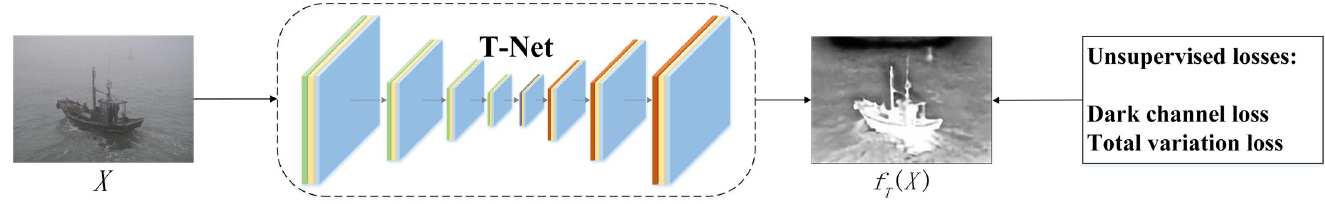
Fig 6. Transmission map estimation branch, dark channel loss and total variation loss are used to constrain the network whose output is a single channel transmission map.